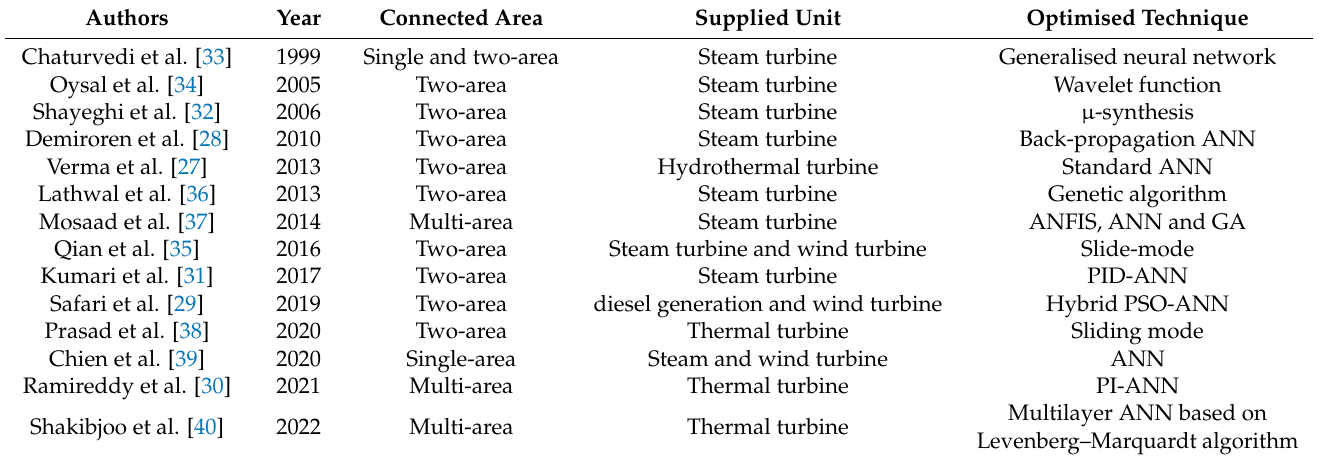
Table 1. Summary literature reviews for using ANN technique in LFC